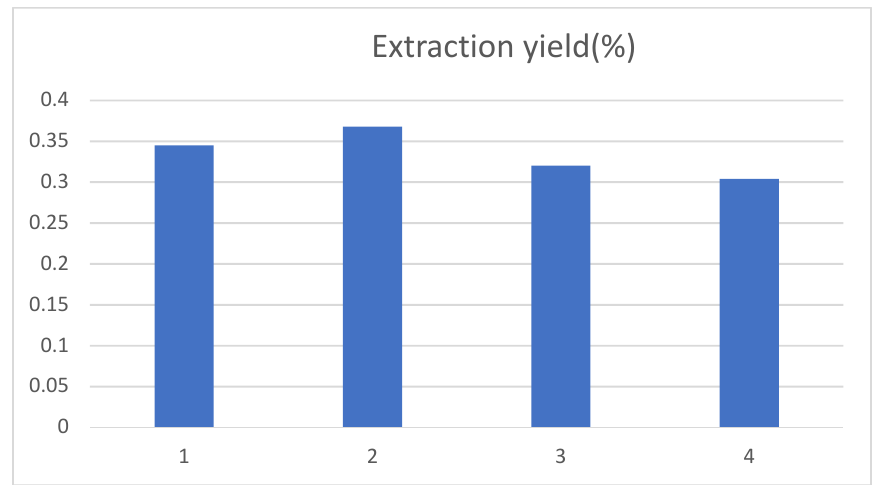
Figure 3. Influence of ethanol volume fraction on the extraction yield of chlorogenic acid, and 1, 2, 3, and 4 represent the ethanol volume fraction of 40%, 50%, 60% and 70%, respectively.